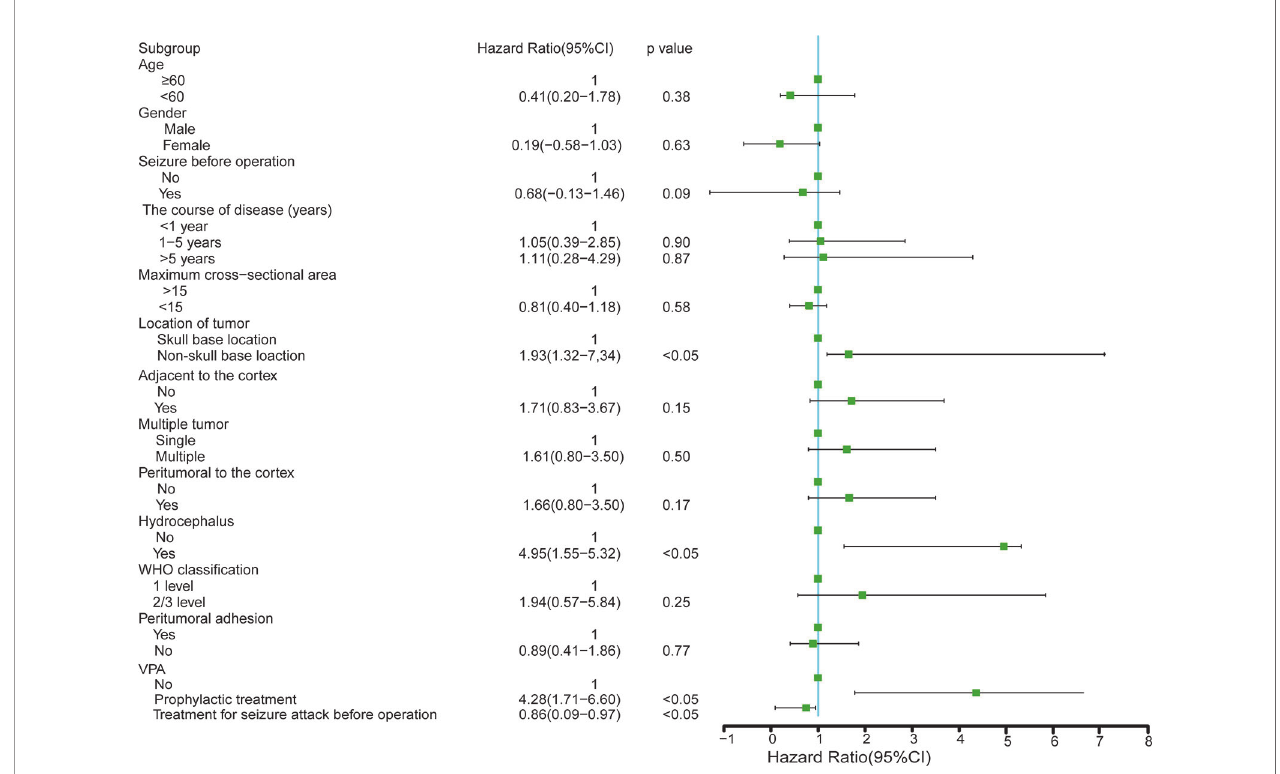
FIGURE 2 | Study population for a univariate logistic regression